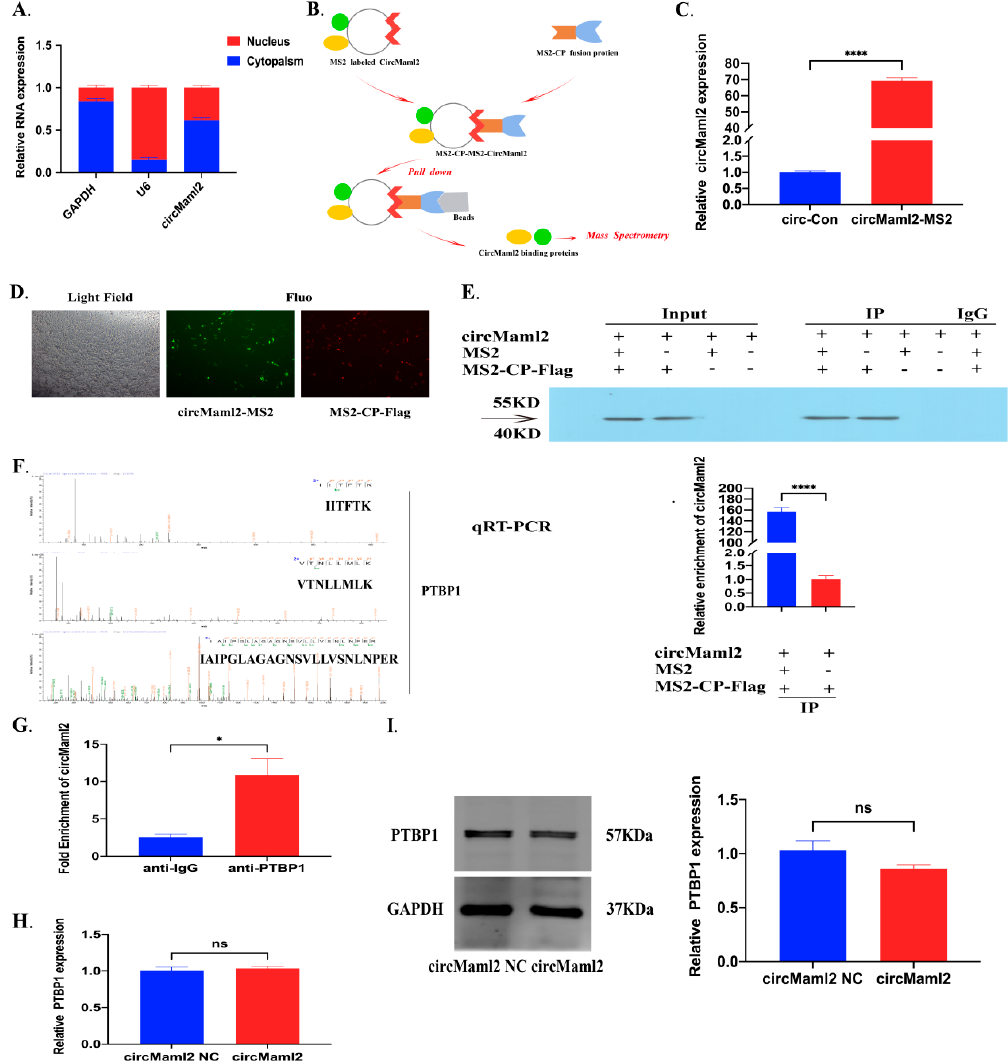
Figure 2. CircMaml2 Directly Interacts with the RBP PTBP1. ( A ) Subcellular location of circMaml2 in MC38 cells. ( B ) In vivo circRNA pull-down using the MS2-tagging system and subsequent label- free mass spectrometric analysis (MS). ( C ) Confirmation of the overexpression of circMaml2 using qRT-PCR analysis (**** p < 0.0001, t test). ( D ) Co-transfection of circMaml2-MS2 and MS2-CP-Flag plasmids to induce the expression of MS2 RNA hairpins with overexpressed circMaml2 and a fusion protein MS2-CP-Flag, which could recognize MS2 RNA hairpins. The green fluorescence-labeled circMaml2 (up) and the red fluorescence-labeled MS2-CP-Flag (bottom). ( E ) Western Blot test the MS2-CP-Flag pulled down by anti-Flag (up). The enrichment of circMaml2 in the complex with MS2-CP-Flag was detected by qRT-PCR (bottom) (**** p < 0.0001, t test). ( F ) A label-free MS was used to test the protein complex with MS2-CP-Flag. The peptides were matched to PTBP1. ( G ) The immunoprecipitation assay (RIP) measures the amount of circMaml2 pulled down by PTBP1 and IgG antibodies in MC38 cells (* p = 0.0196, t test). ( H , I ) Both qRT-PCR and Western blot detected PTBP1 expression in circMaml2-overexpressing cells. All data are presented as mean + SEM. ns, not significant. n =